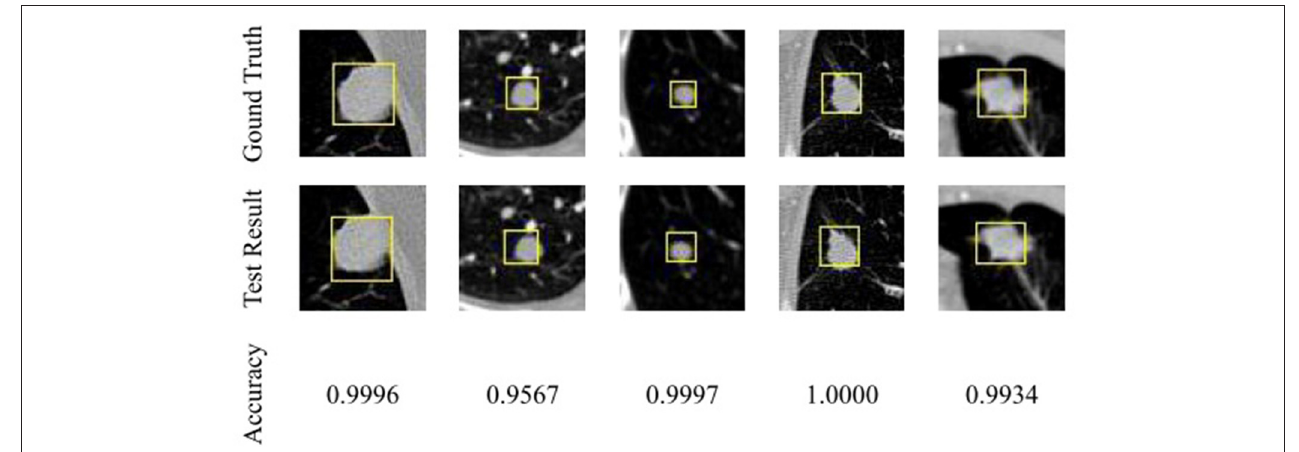
FIGURE 2 | Comparison of pulmonary nodules test results and actual